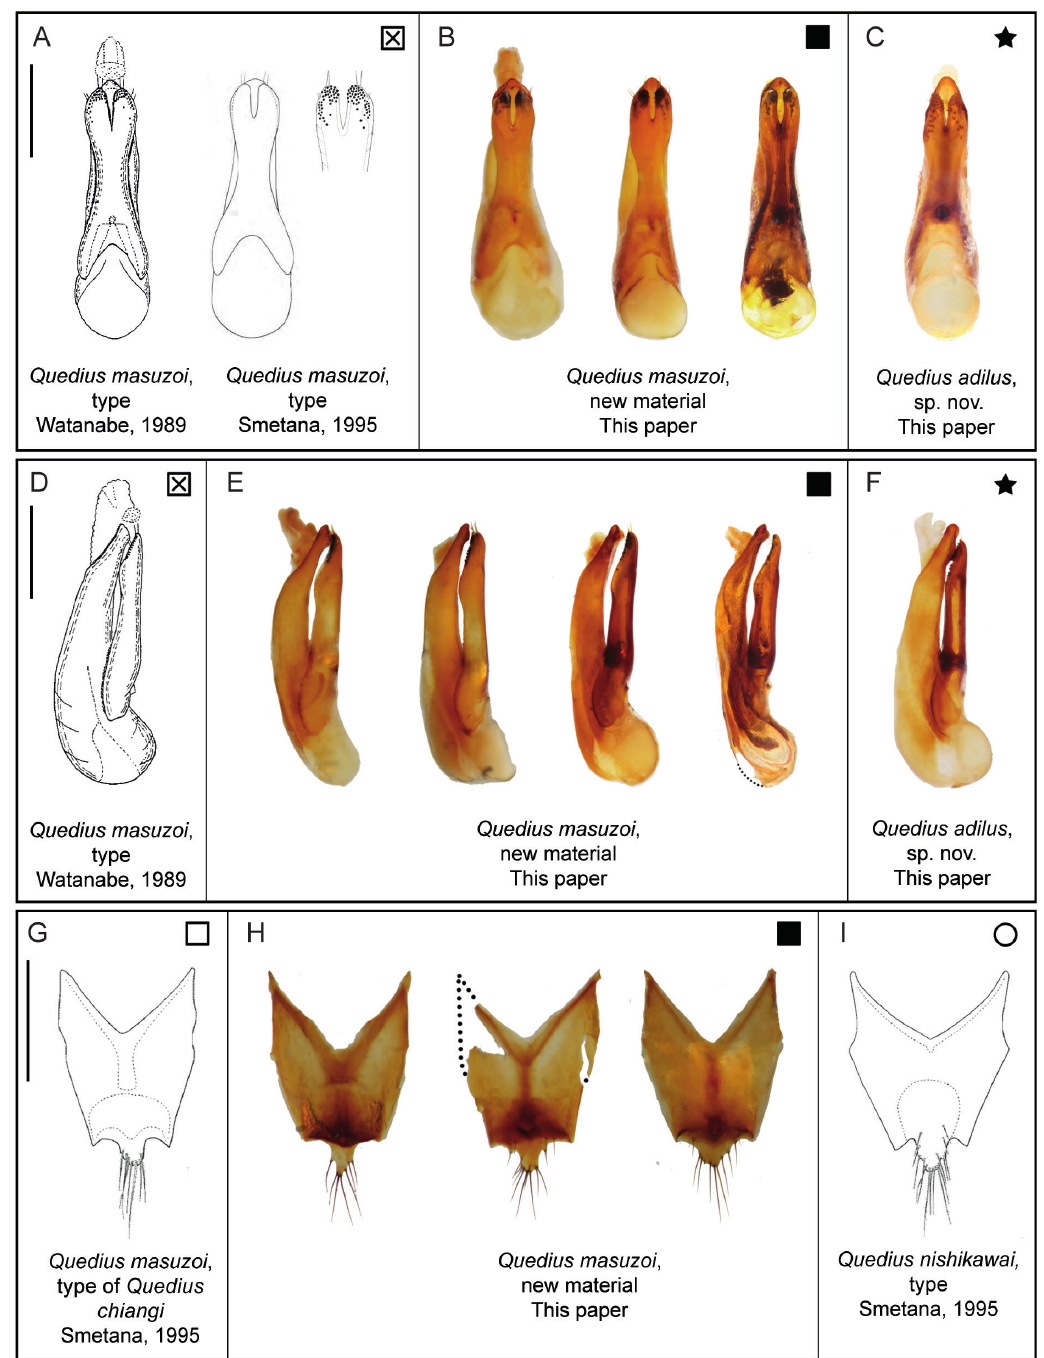
Fig. 3. Aedeagi and female terminalia of species of the Quedius abnormalis group from Taiwan. The graphic symbol on each illustration refers to the collection locality on Fig. 2 as follows: filled square  to the new specimens of Quedius masuzoi Watanabe, 1989 reported in this paper; square with cross  to the male holotype of Quedius masuzoi ; unfilled square  to the female holotype of Quedius chiangi Smetana, 1995, synonym of Q. masuzoi ; unfilled circle  to the female holotype of Quedius nishikawai Watanabe, 1991; filled star  to the male holotype of Quedius adilus sp. nov. Top row ( A–C ): parameral view of aedeagus. Middle row ( D–F ): lateral view of aedeagus. Bottom row ( G–I ): female tergite X. Scale bars = 0.5